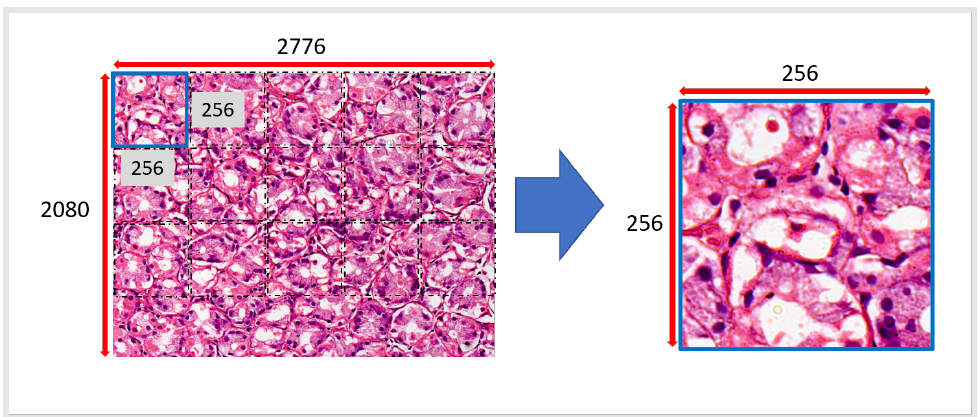
Figure 2. A random example of the original H&E image (2776 × 2080 pixels) and one patch sized to 256 × 256 pixels.